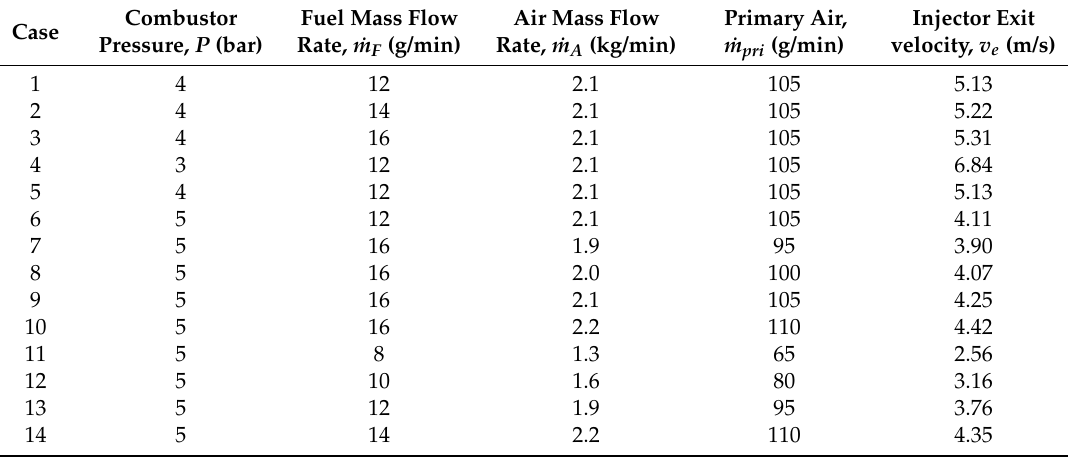
Table 1. Test cases of the